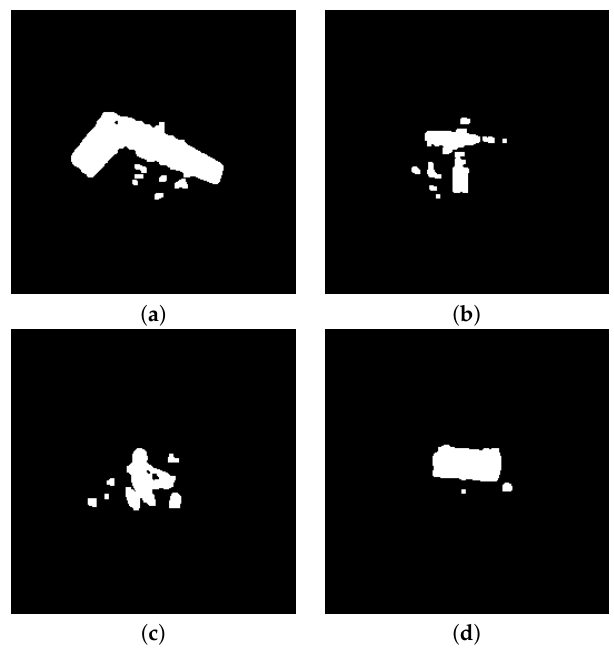
Figure 12. Segmentation of ‘V’ images, at frequency 94 GHz: ( a ) concealed gun, ( b ) knife, ( c ) keys, ( d )